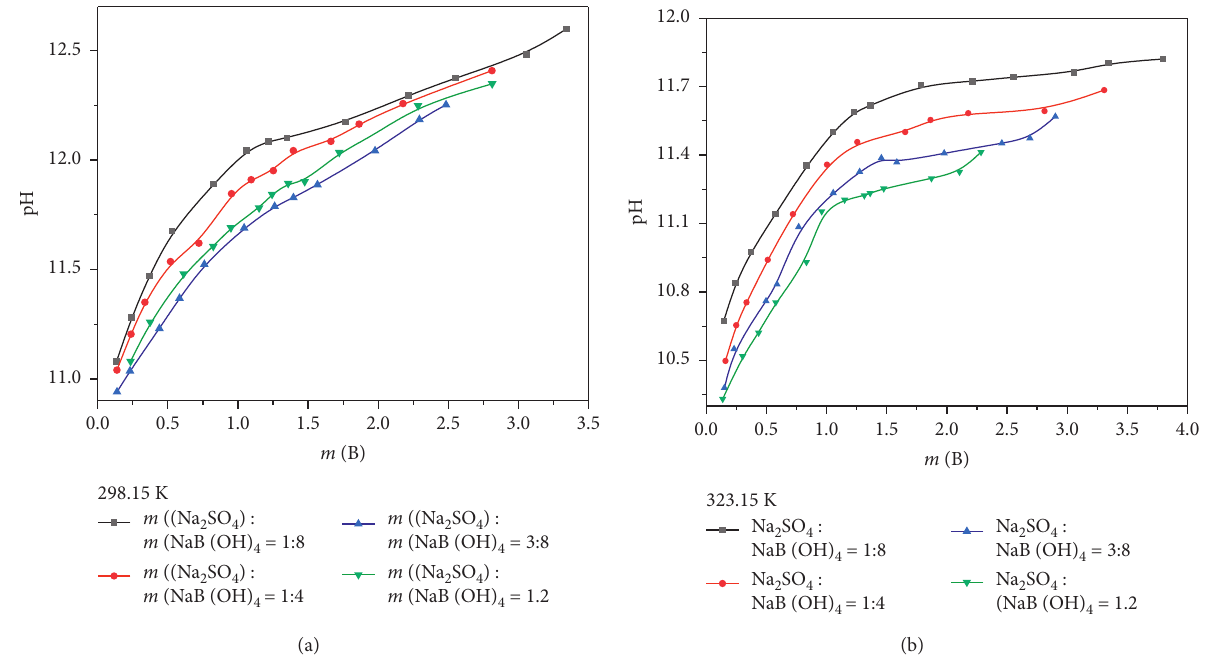
Figure 3: The pH of mixed solution in the NaB(OH) 4 –Na 2 SO 4 –H 2 O system. (a) 298.15K. (b) 323.15K. Black line, m (Na 2 SO 4 ): m (NaB(OH) 4 ) � 1 :8; red line, m (Na 2 SO 4 ): m (NaB(OH) 4 ) � 1: 4; blue line, m (Na 2 SO 4 ): m (NaB(OH) 4 ) � 3 :8; green line, m (Na 2 SO 4 ): m (NaB(OH) 4 ) � 1 :2.